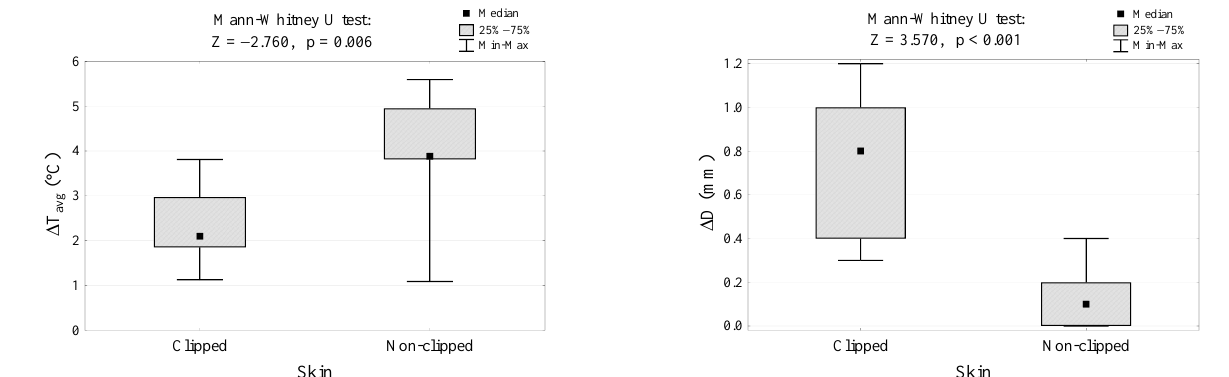
Figure 3. Differences in skin surface temperature and vein diameter after HILT in the clipped and non-clipped coat groups. ∆ Tavg, differences between values of skin surface temperature after HILT; ∆ D , differences between values of vein diameter after HILT.